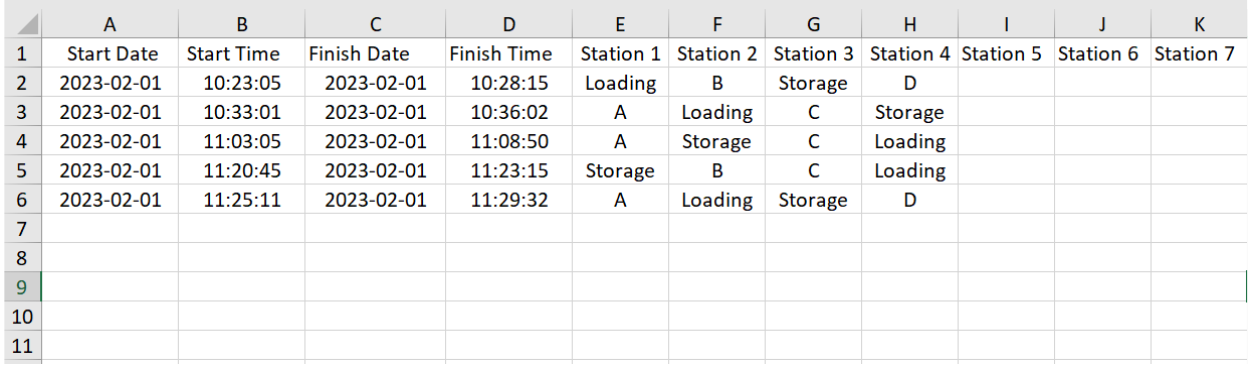
Figure 6. Screenshot of Excel table that allows the work order to be executed.